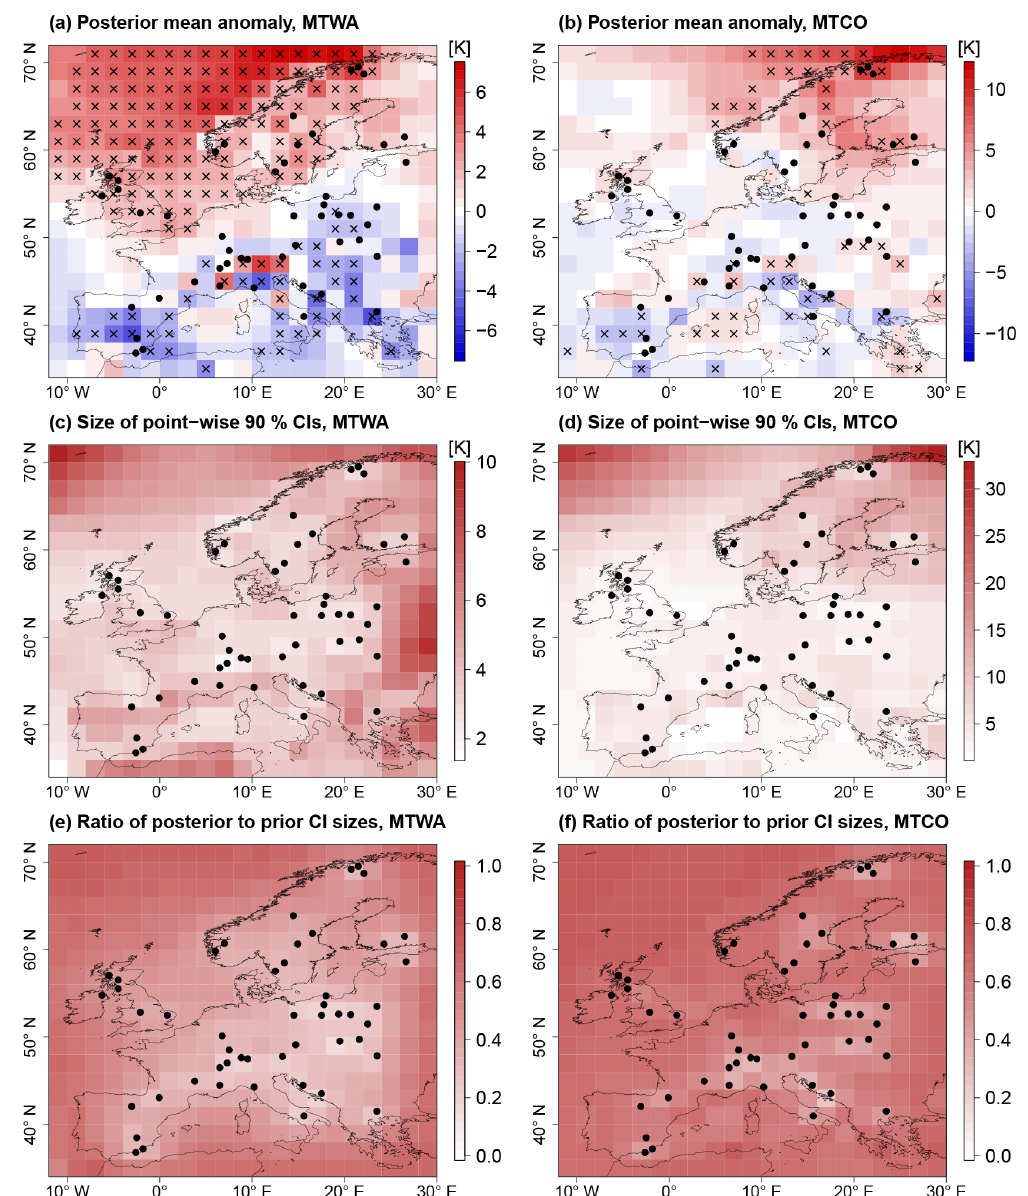
Figure 7. Spatial reconstruction for MH. (a, b) Posterior mean anomaly from CRU reference climatology; point-wise significant anomalies (5% level) are marked by black crosses. (c, d) Reconstruction uncertainty plotted as the size of point-wise 90% CIs and (e, f) reduction of uncertainty from posterior to prior measured by the ratio of posterior to prior point-wise 90% CI sizes. Black dots depict proxy samples.